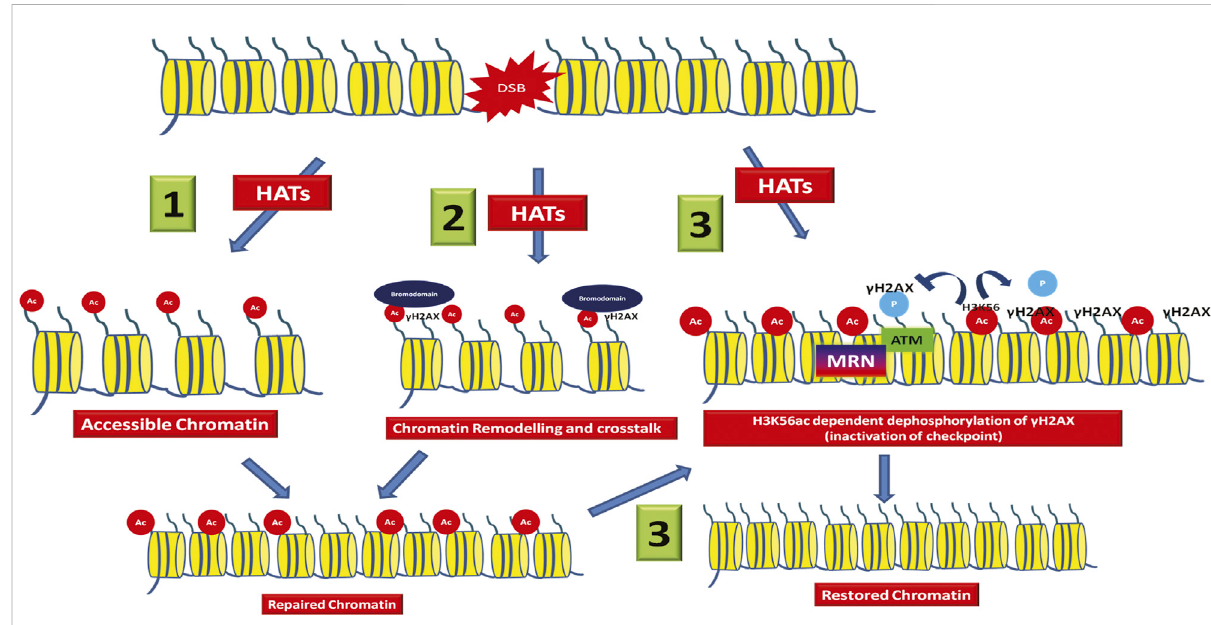
FIGURE 1 Different roles of histone acetylation at the DSB. At the DSB, acetylation of histones by the action of histone acetyltransferases leads to- 1) Chargebasedincreaseinchromatinaccessibilityleadingtorecruitmentofrepairfactors.2)Theacetylatedhistonesarerecognizedbyacetylreaders like bromodomain containing proteins, which in turn leads to chromatin remodelling around the break and DDR factor recruitment. 3) Some modi fi cations like H3K56ac helps in inactivation of checkpoint and therefore leads to chromatin restoration to its native